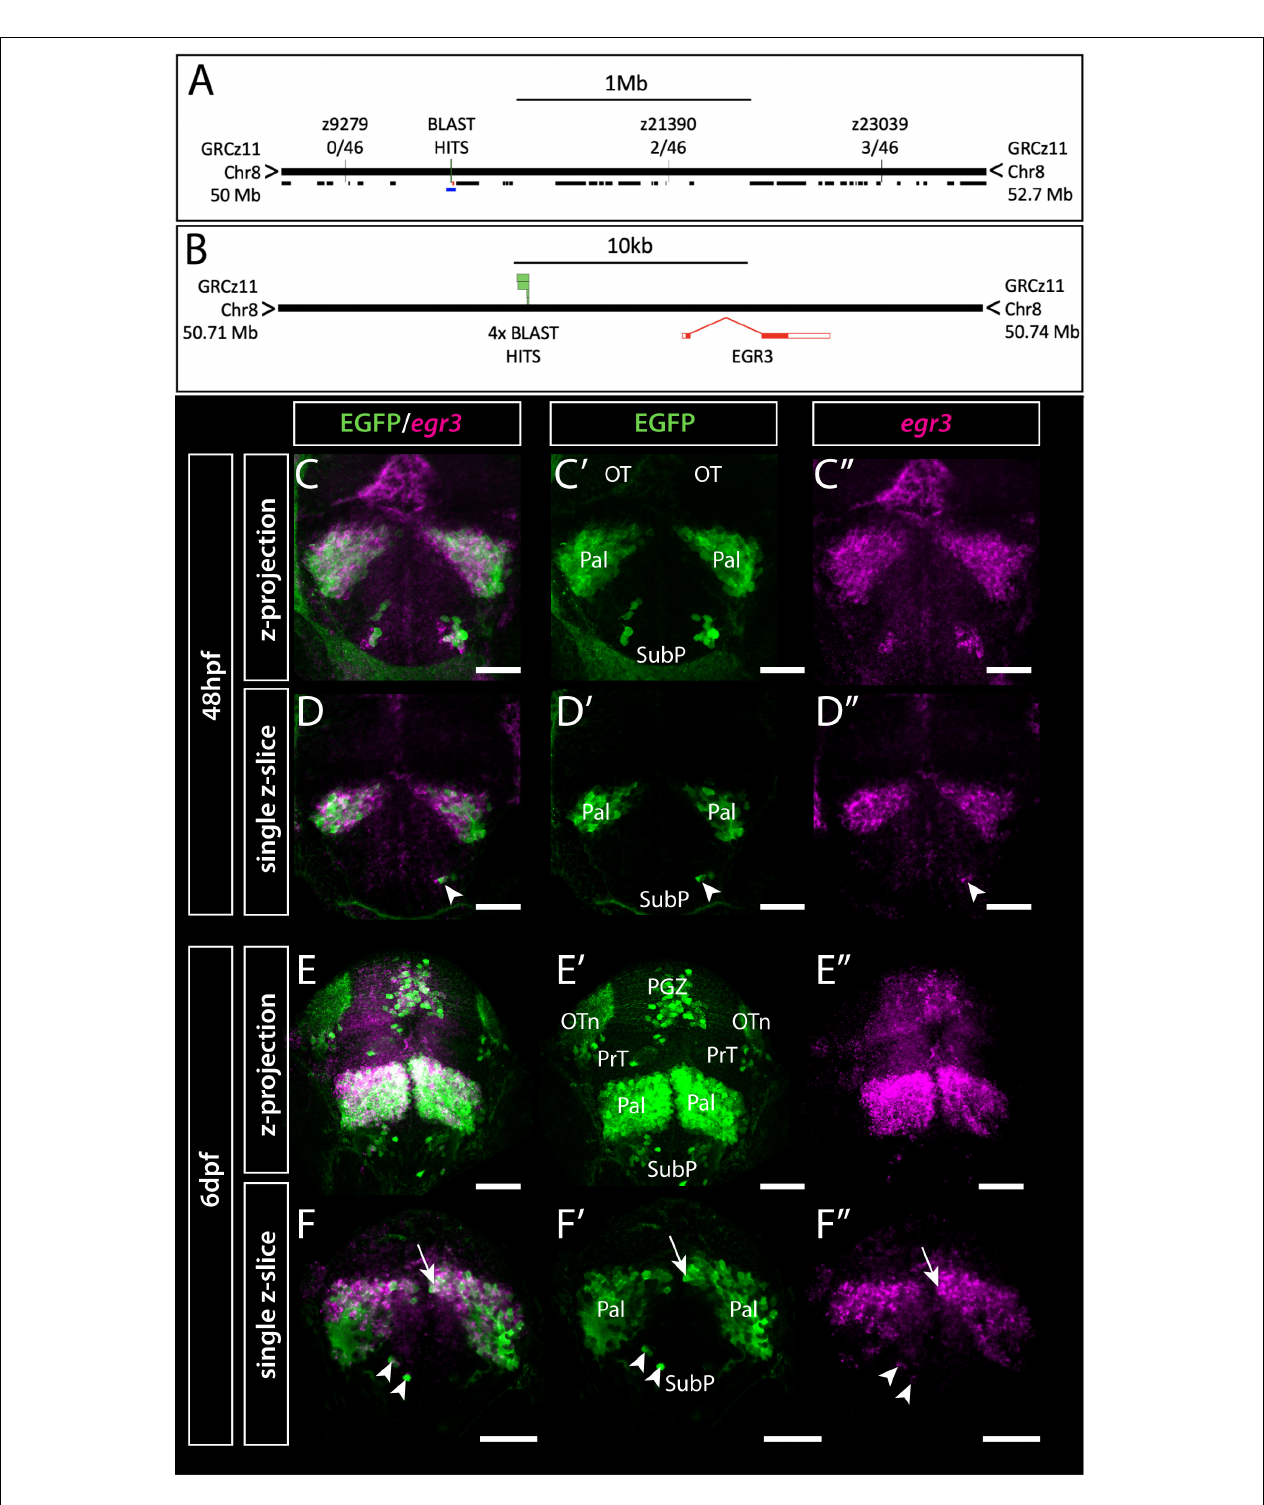
FIGURE 1 | Et( gata2:EGFP ) bi105 insertion is located near egr3 and expression of egr3 matches transgene expression. (A,B) Mapping of Et (gata2:EGFP) bi105 insertion showing the position of Genome Walker BLAST hits on assembly GRCz11, relative position of neighboring genes (black lines) and linkage markers with meiotic recombination data (A), the lower blue line in panel (A) indicates the region around egr3 shown in panel (B) , with BLAST hits (insertion) locations. BLAST/BLAT coordinates: 8:50720195-50720677 (C–F (cid:48)(cid:48) ) Immunostaining and in situ hybridization showing EGFP and egr3 mRNA co-expression in the telencephalon and optic tectum of Et (gata2:EGFP) bi105 fish at 48 hpf (C–D (cid:48)(cid:48) ) and 6 dpf (E–F (cid:48)(cid:48) ) in frontal view. Panels (C–C (cid:48)(cid:48) ,E–E (cid:48)(cid:48) ) show z-projections and panels (D–D (cid:48)(cid:48) ,F–F (cid:48)(cid:48) ) show single z-slices. Note the co-expression of EGFP and egr3 in pallial (arrow) and subpallial (arrowheads) cells. Scale bars: 50 µ m.